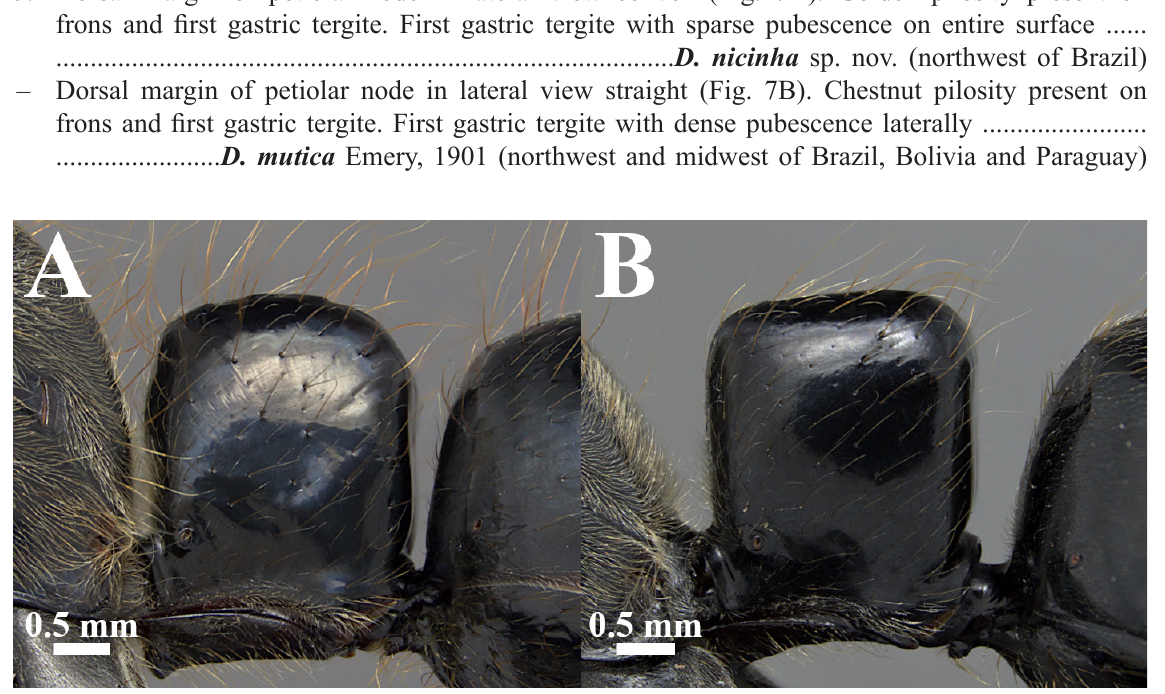
Fig. 7. Petiolar node in lateral view. A . Dinoponera nicinha sp. nov. B . D . mutica Emery, 1901.